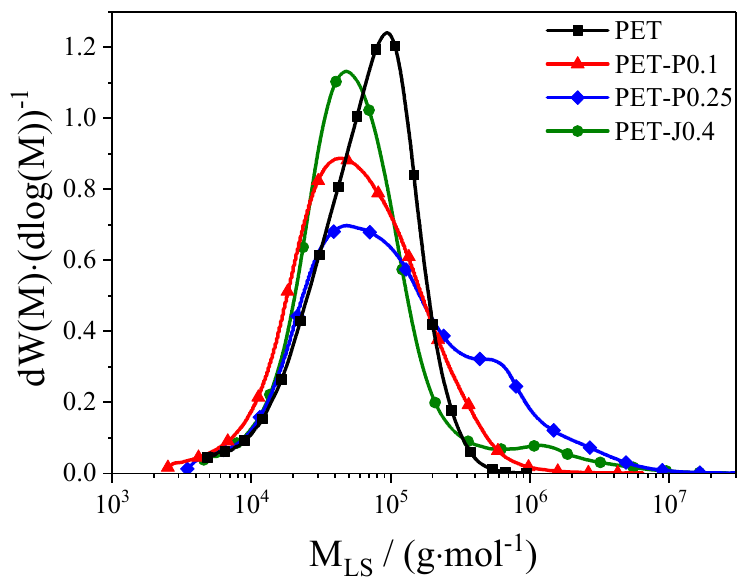
Figure 1. Logarithmic derivative of the cumulative molar mass distribution W (M) as a function of the absolute molar mass M LS determined by light scattering for PET modified with PMDA or Joncryl [8,9]. The numbers of the PET samples describe the weight percentages of the modifier Joncryl (J) or PMDA (P).